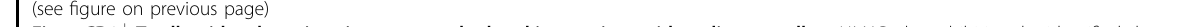
Fig. 5 CD8 + T cells with exhaustion signatures and related interactions with malignant cells. a UMAP plot exhibiting the identi fi ed clusters of T cells in the 10× dataset. b Histogram showing cell type percentages of different T cells from collected samples in the 10× dataset. c Dot plots presenting the normalized expression levels of corresponding markers of T cell clusters in the 10× dataset. d Scatterplot showing DEGs of T cells from tumor tissues compared with normal tissues in both CD4 + and CD8 + T cells. e Violin plots showing expression of the exhaustion and cytotoxicity gene sets in CD8 + T cells from tumor and normal tissues. The P value was calculated by t -test. f Representative IHC staining of TIM3 in adjacent normal and primary tumor tissues (original magni fi cation 100×). The rows of the paired normal and tumor samples are from the same patients, and three individual patients are listed. Scale bar, 100 μ m. g Dot plot showing the expression of interaction pairs in epithelial cell and T cell pairs with different